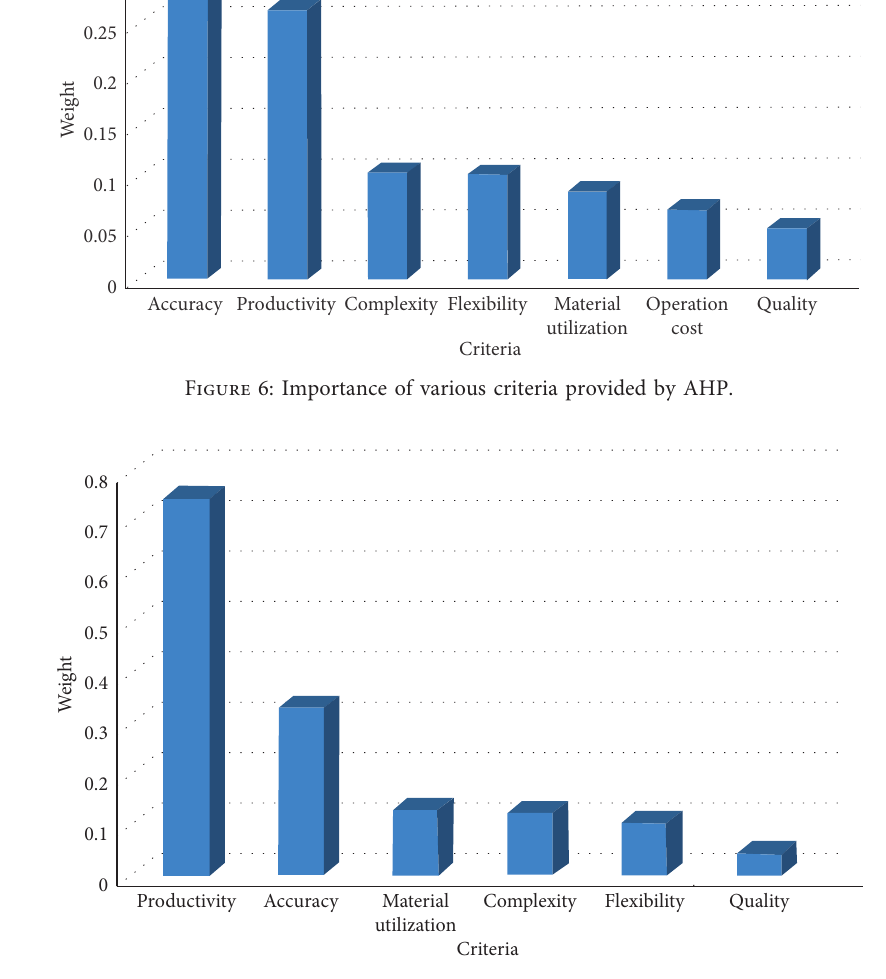
Figure 7: Importance order obtained after removal of criteria in